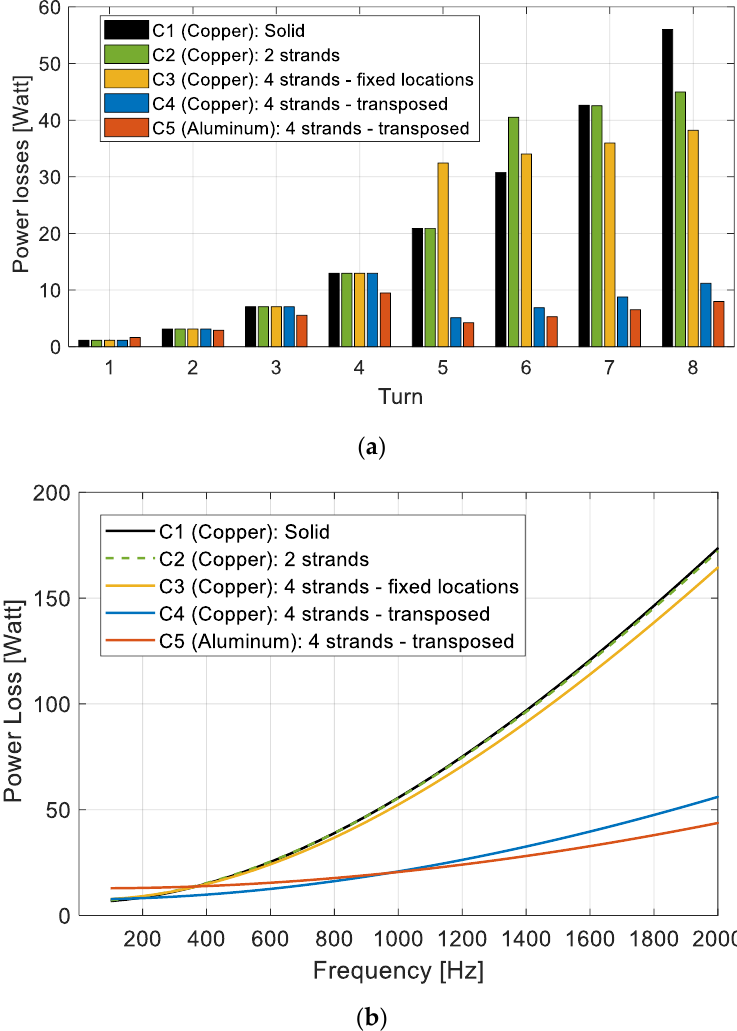
Figure 5. Comparison between the solid single-strand copper coil and the semi-stranded coils. ( a ) Total losses in each turn at high frequency of 2 kHz; ( b ) total losses in the entire coil at different frequency levels.